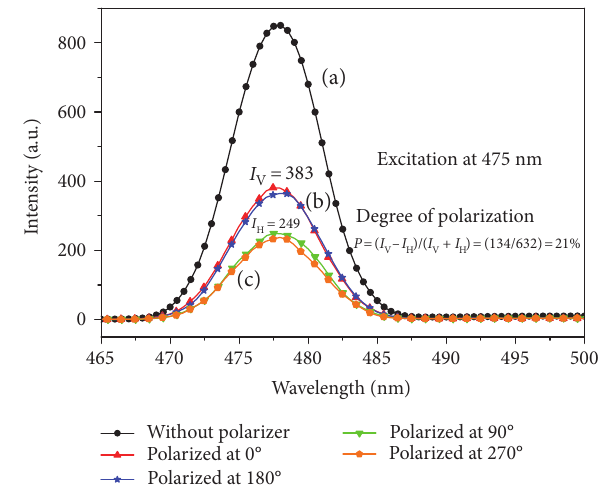
Figure 8: Polarization of Rayleigh scattering of acetone. (a) Black line; (b) blue and red line; (c) green and orange line.